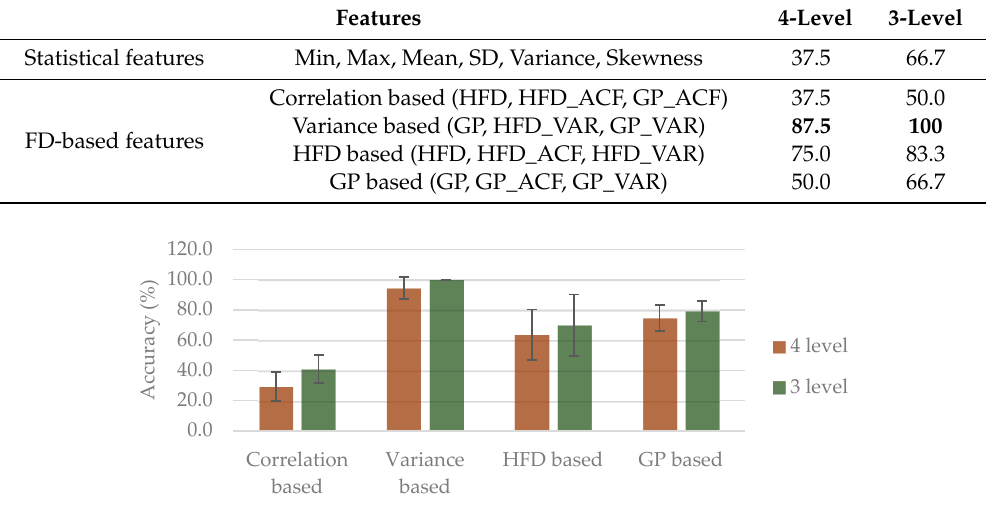
Figure 5. 5-fold cross validation accuracy (%) based on di ff erent combined features. The error bars are Figure 5. 5 ‐ fold cross validation accuracy (%) based on different combined features. The error bars are the standard error with regard of the mean. the standard error with regard of the